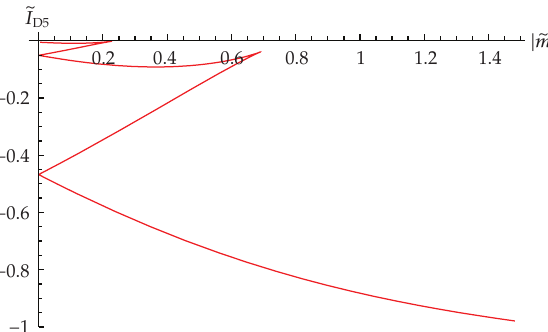
Figure 8: The states corresponding to the lowest positive branch of the plot in Figure 7 have the lowest free energy and thus correspond to the stable phase of the